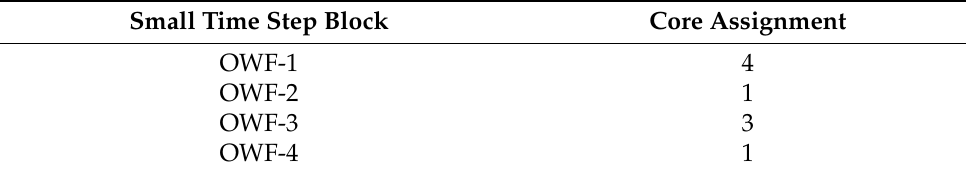
Table 1. Core assignment of OWF models in